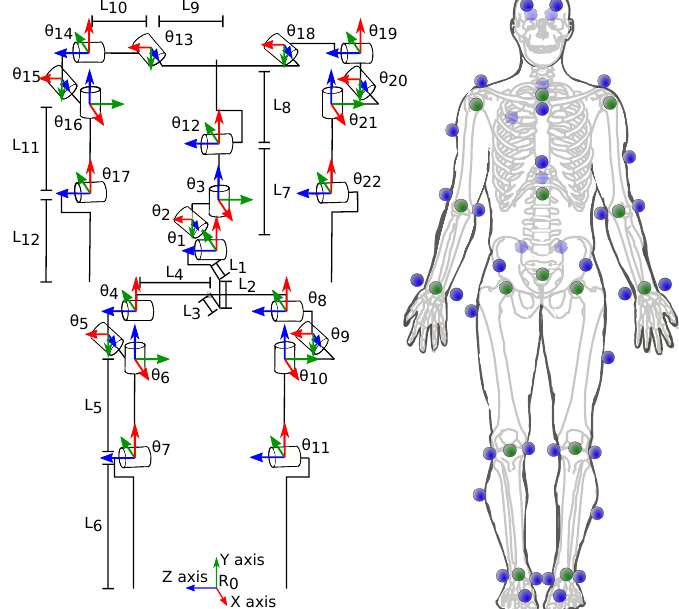
Figure 1. ( Left ) A 22 degree-of-freedom model of the locomotor system. θ i is the i th joint angle corresponding to a rotation along the i th local Z axis and L j is the length of the segment j . ( Right ) Location of the retro-reflective markers (blue), used by the reference stereophotogrammetric system (SS), and of the Kinect sensor (K2S)-estimated joint center position (JCP)